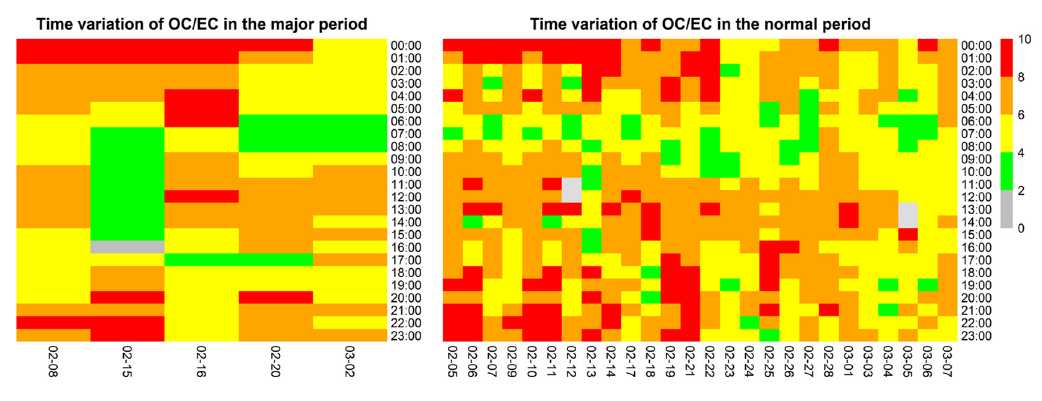
Figure 8. Temporal variation of OC / EC ratio by major and normal periods.